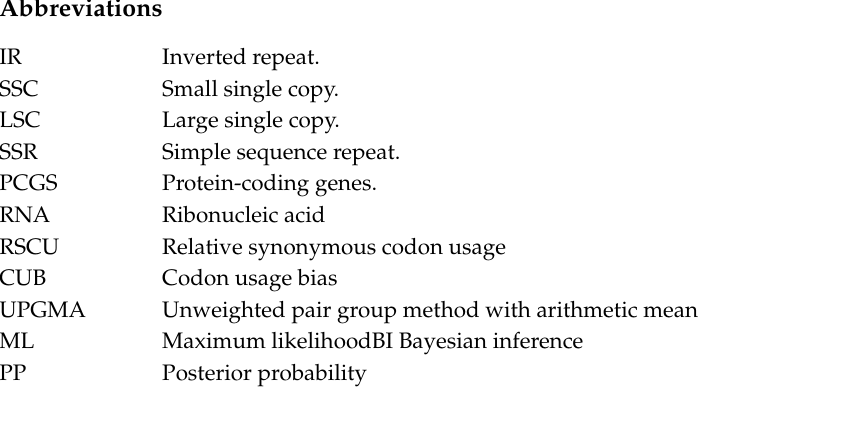
Table S1. Details of taxa used in phylogenetic analyses. Table S2. Details of codon usage and relative synonymous codon usage values of chloroplast genomes of 12 species of Nymphaeaceae. Table S3. Details of RNA-editing gene transcript. Table S4. Details of short and long repetitive sequences discovered in each of the chloroplast genomes of 12 species of